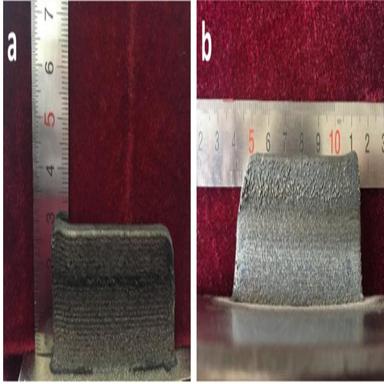
Photograph of specimen: (a) The measurement of Sample height. (b) The measurement of sample length.